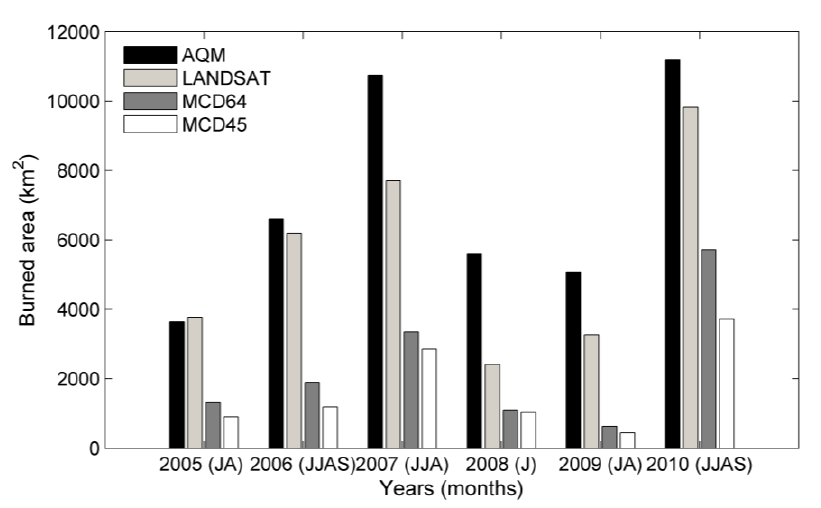
Figure 7. Histogram representing the results of BA for the Jalapão region comparing AQM, MCD45, MCD64, and the TM reference maps for the years (months) studied.